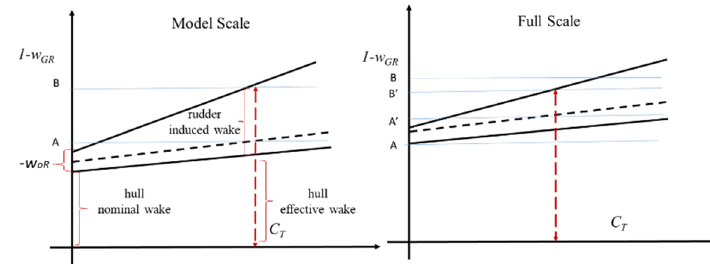
Figure 13. Schematic diagram of the scale effect of the wake of a gate rudder propulsion system.